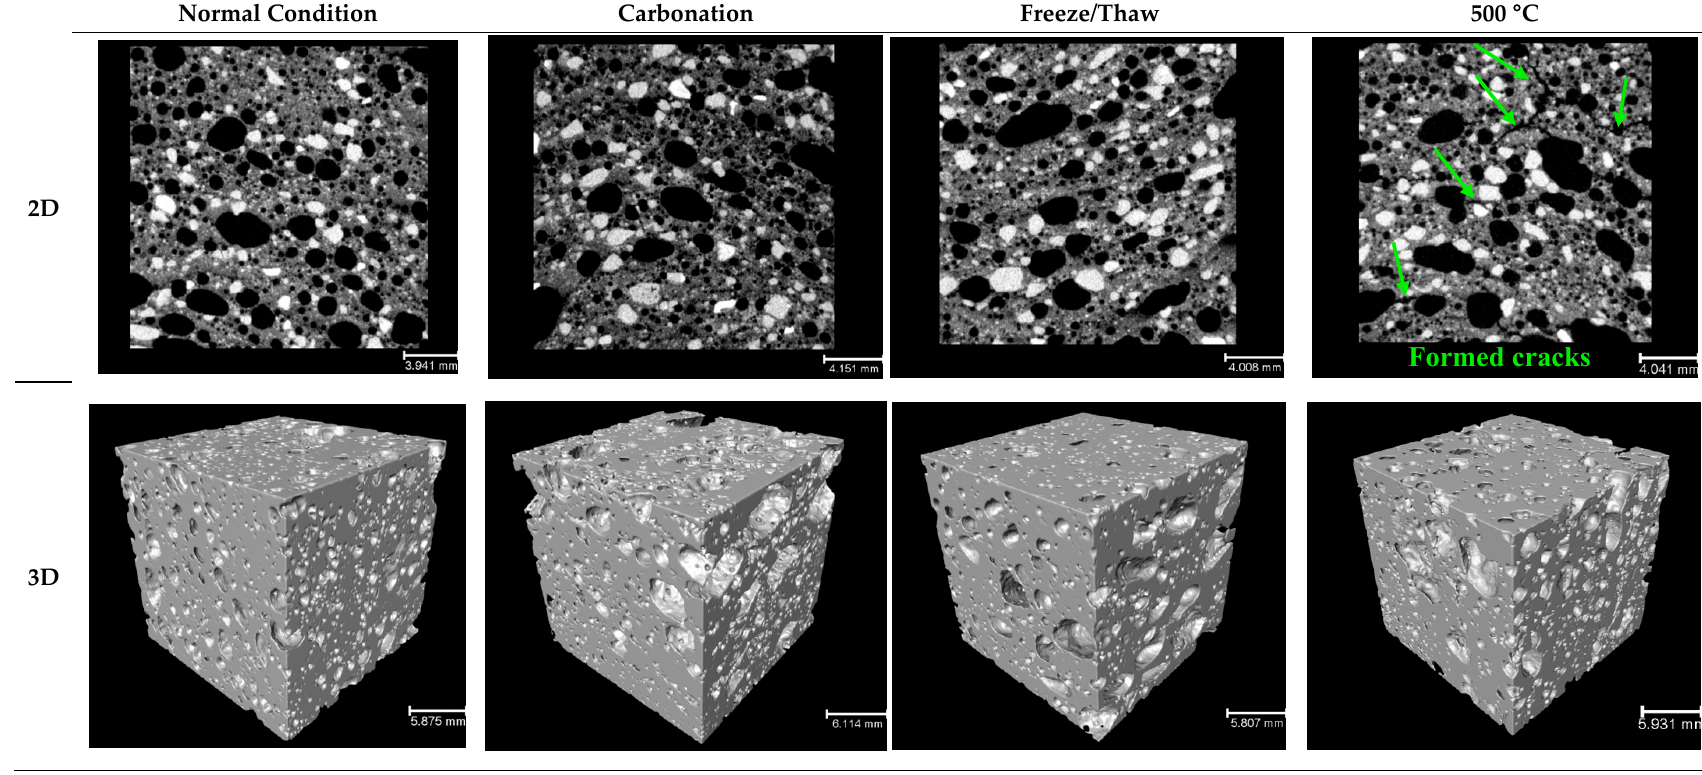
Figure 20. Representative 2D and 3D reconstructions of SW30/GW30-2% Fiber-35% Foam, showing the effects of different test conditions on the porous structure.